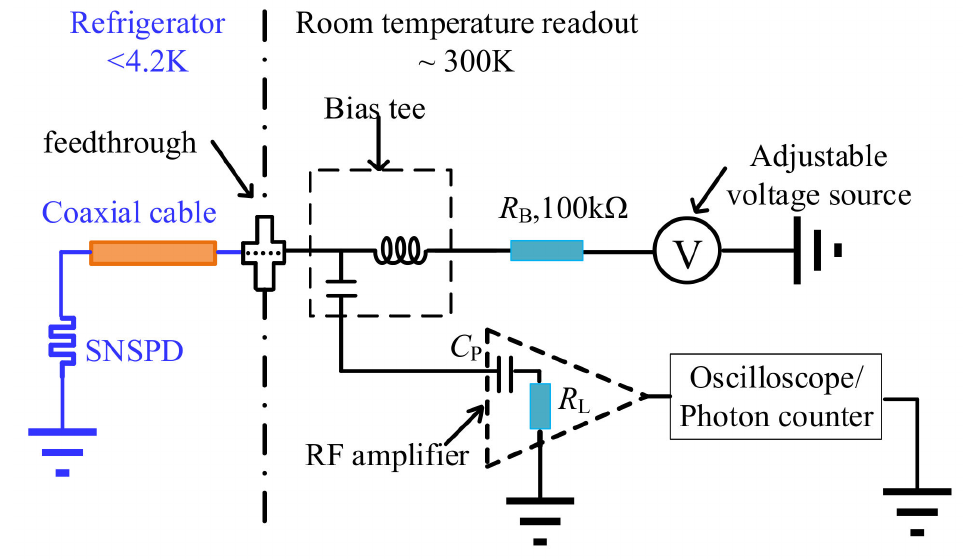
Figure 1. The traditional SNSPD readout scheme.